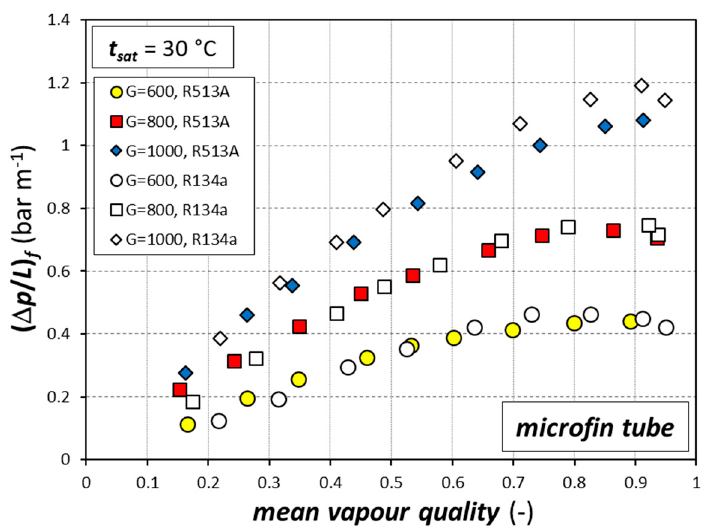
Figure 10. R134a and R513A frictional pressure gradient for the microfin tube vs. mean vapor quality at t sat = 30 °C. G expressed in [kg m − 2 s − 1 ].